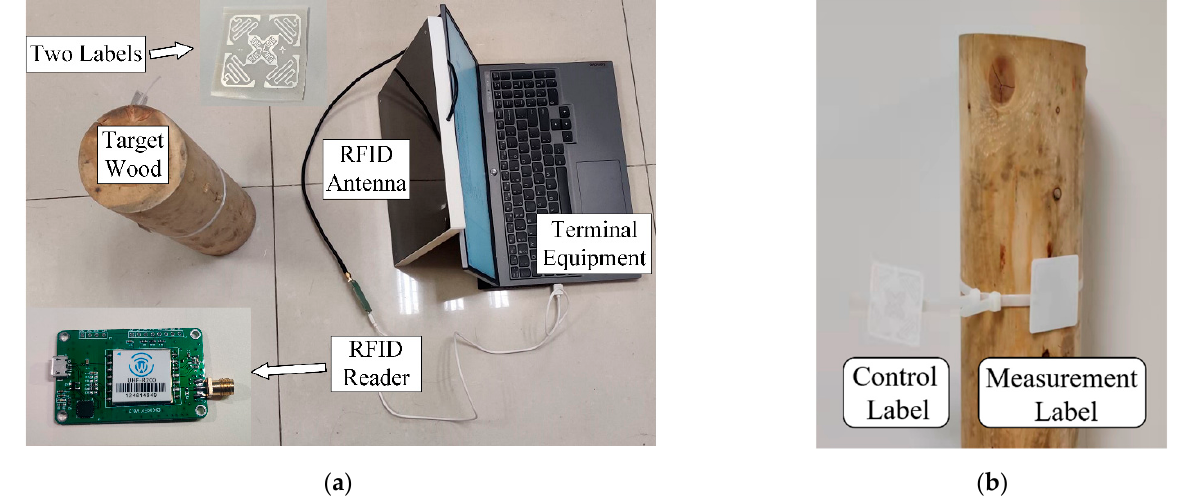
Figure 8. Laboratory experimental scenario with the boxwood sample. ( a ) shows the setup for the actual measurement in the laboratory, and ( b ) shows an example of the sticker attached to the tree.